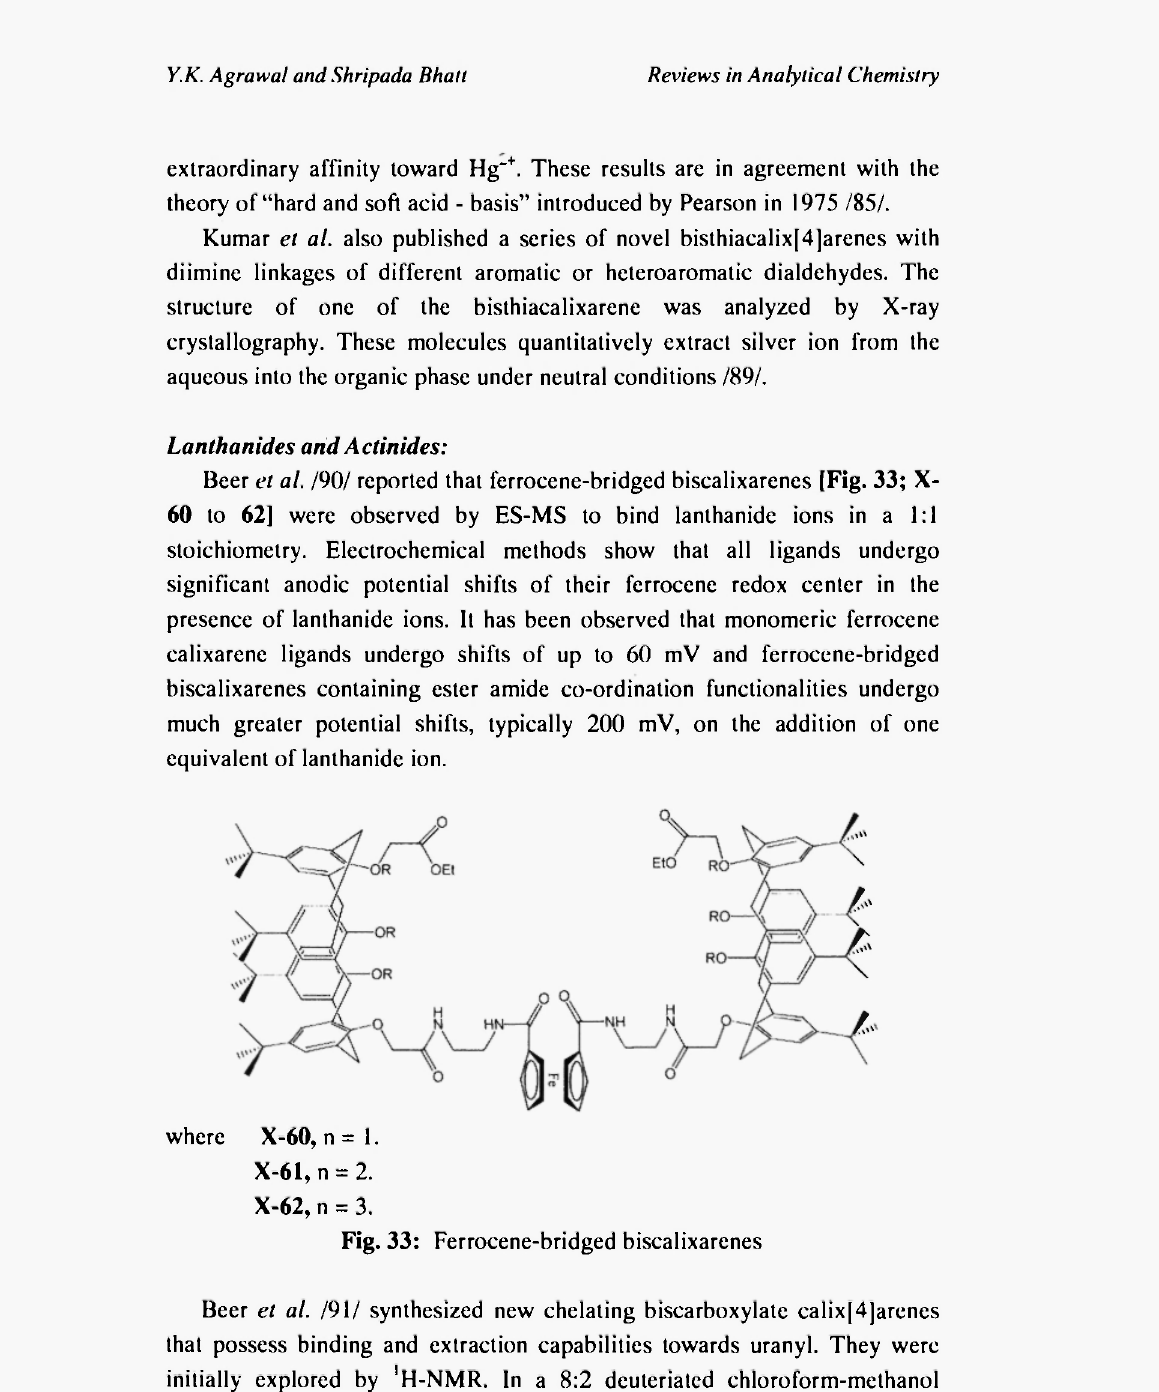
Fig. 33: Ferrocene-bridged